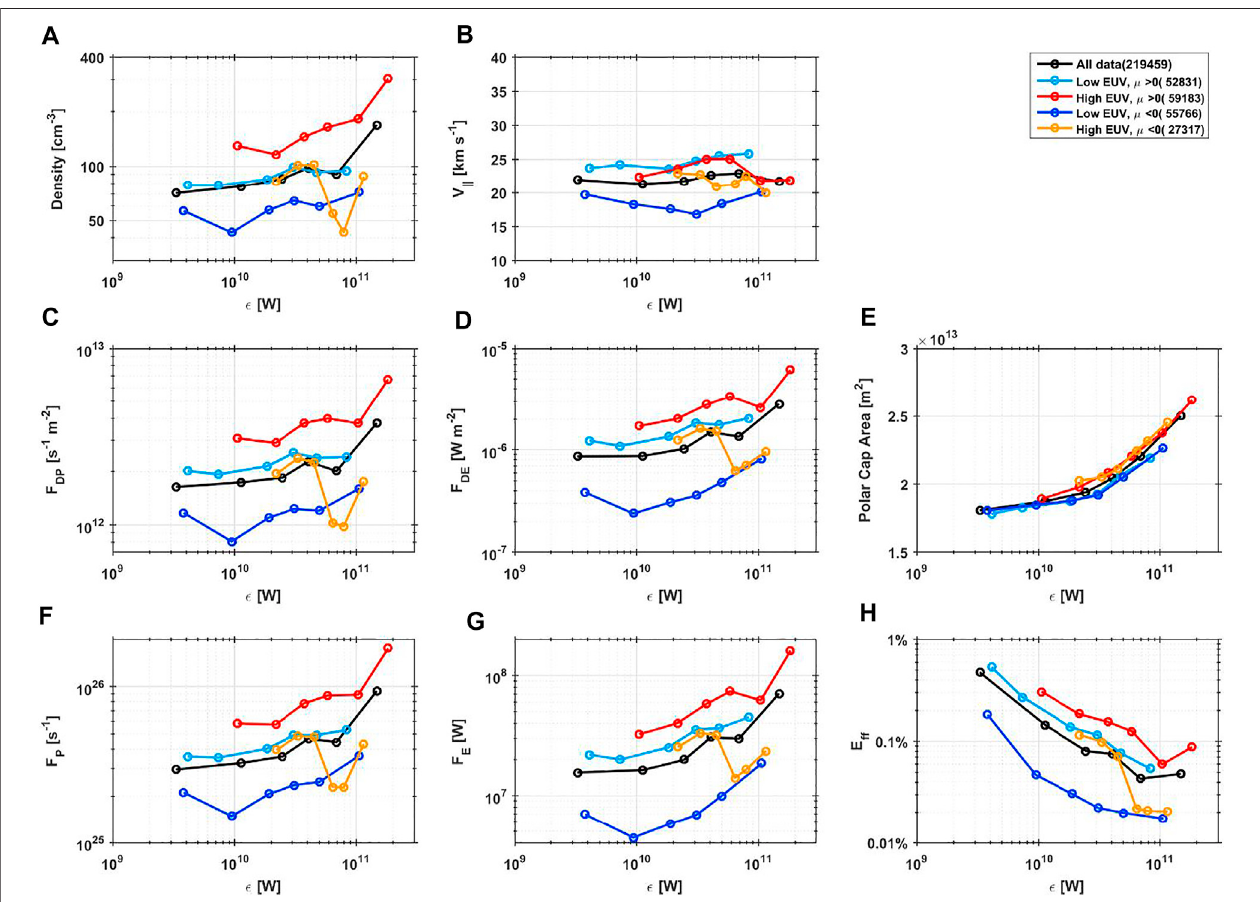
FIGURE5| Coldionout fl owparametersinthetopsideionosphereasafunctionofthe ε parameter underdifferentconditionsofsolarEUVand geomagneticdipole tiltangle( μ ).Eachpanelshowsmedianvaluescalculatedfromthe10-yearsdatasetdescribedin DataSetofColdIons .HighandlowsolarEUVarede fi nedasF 10.7 being higher and lower than 155, respectively. F DP and F P stand for out fl ow particle fl ux and out fl ow rate, respectively. F DE and F E are out fl ow energy fl ux and out fl ow power, respectively. E ff is the energy coupling coef fi cient calculated from E ff (cid:1) F E / ε . From Li et al., (2017).